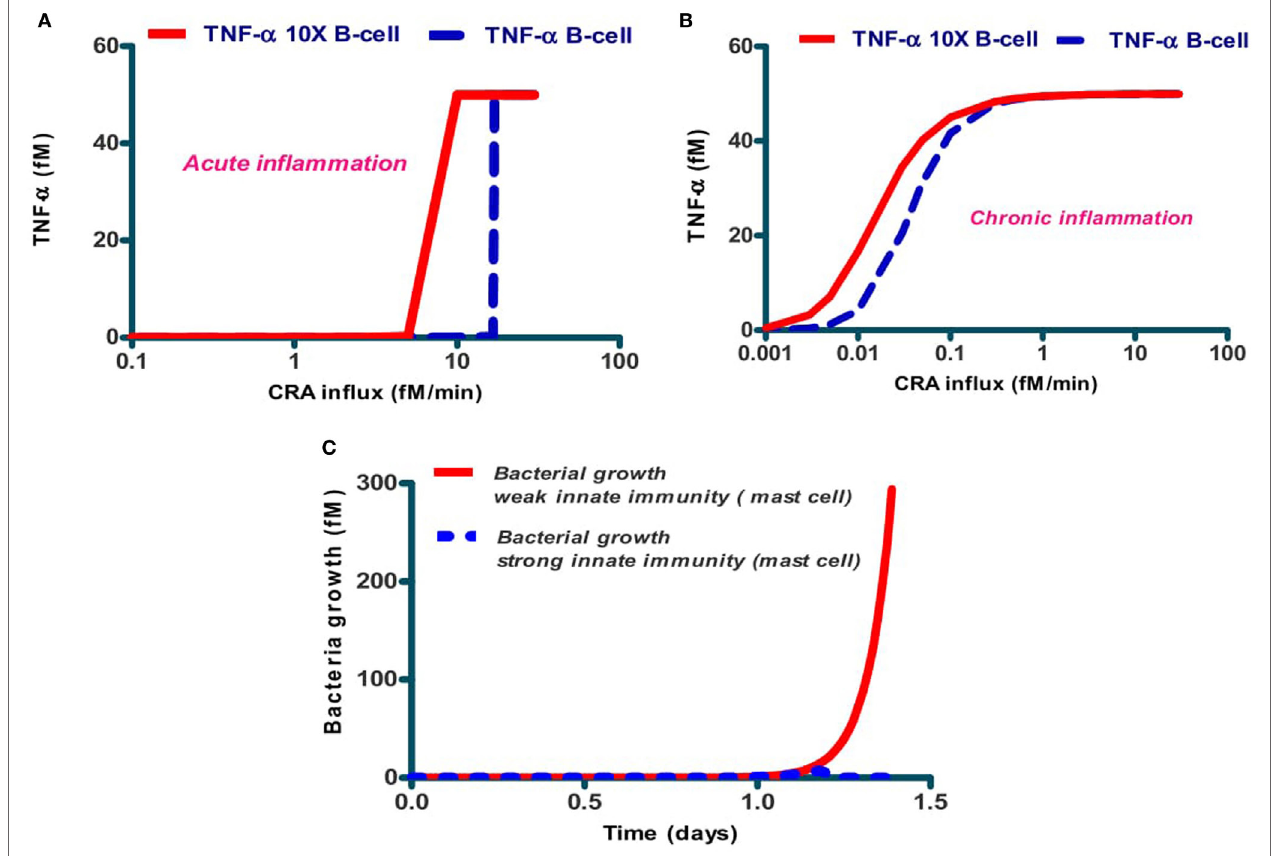
FigUre 7 | Dependence of acute (a) and chronic (B) inflammation on the rate of CRA influx and in bacterial infection (c) depends on the individual's B-cell level. The dashed lines in (a,B) refer to the standard case, while the full lines refer to the same calculations but for five times increased B-cell levels. (c) Dependence of host response in silico on the level of mast cells. The full red line refers to the standard case with 0.1 fM of mast cells, and the dashed blue line (almost coinciding with the abscissa) to the case with 1 fM of mast cells. Protease secretion rate constant for mast cells was k 25 = 65/min and B-cell concentration was 1 fM in both